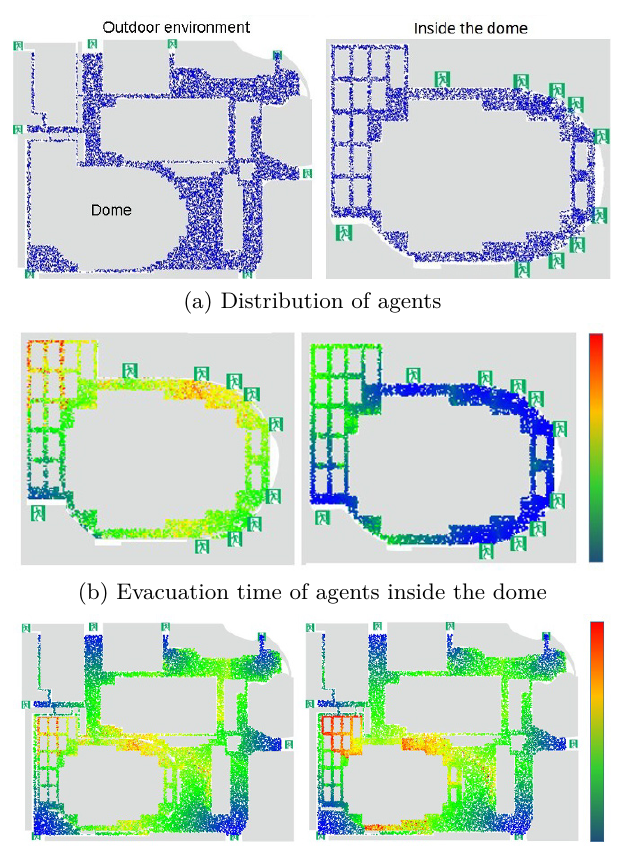
Fig. 16 Park example, showing evacuation time of each agent guided by our optimized evacuation routes. Left, right: routes computed by global and hierarchical schemes respectively. Routes computed hierarchically allow agents to leave the dome faster, but they take longer to leave the park because of congestion in the